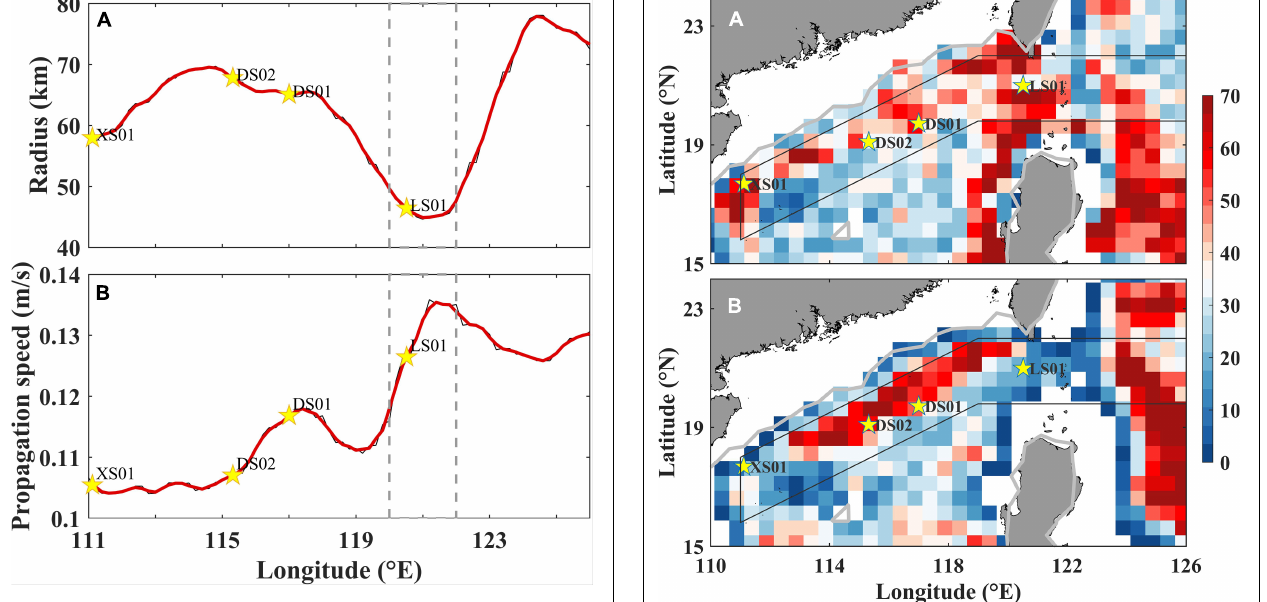
FIGURE 13 | Spatial distribution of (A) the number of eddy radius smaller than 60 km and (B) the number of eddy radius larger than 60